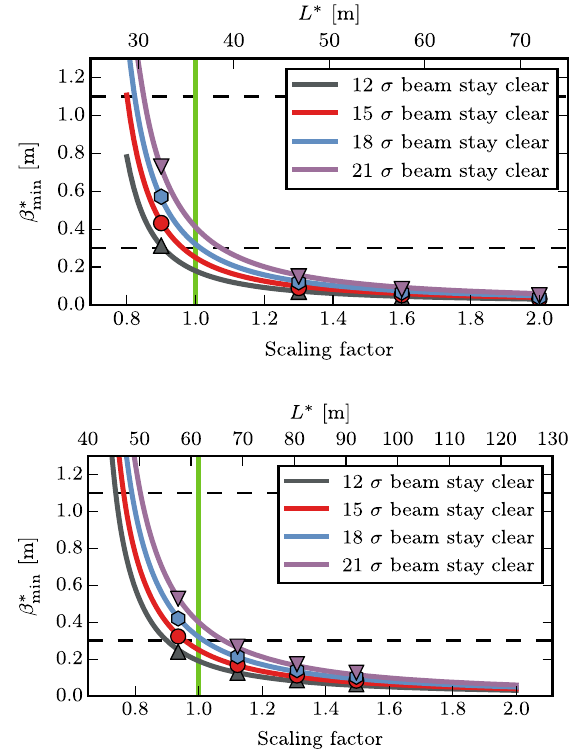
FIG. 10. Minimum β (cid:2) for the L (cid:2) ¼ 36 m lattice (top) and L (cid:2) ¼ 61 . 5 m (bottom) lattice analytically scaled in length, scaling factor and resulting L (cid:2) (top horizontal axis). Markers show β (cid:2) values obtained with MAD-X aperture calculations. The green vertical lines indicate the nonscaled